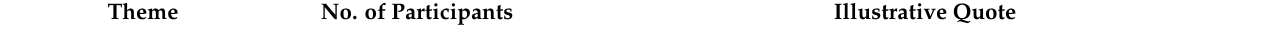
Table 3. Themes and illustrative quotes relating to impact of the COVID-19 pandemic on disaster preparedness and